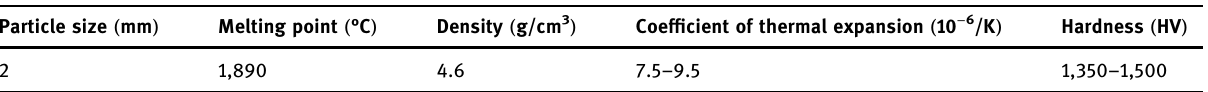
Table 4: Properties of ZTA particles